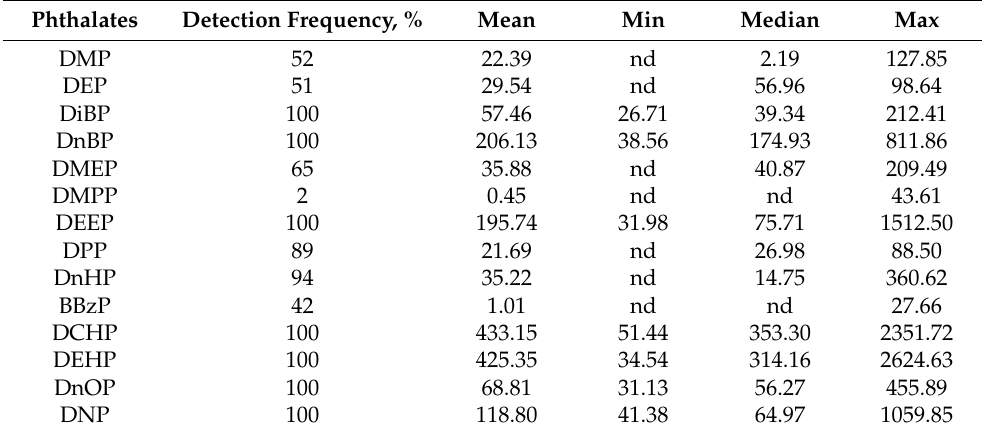
Table 3. Detection frequency and concentrations of phthalates ( µ g/m 2